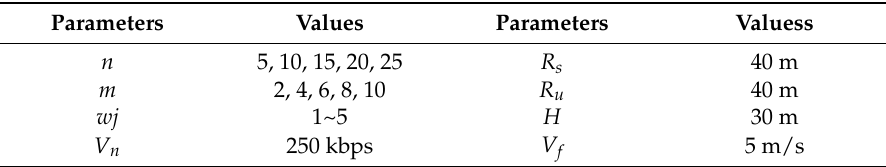
Table 1. The UAV and WSN